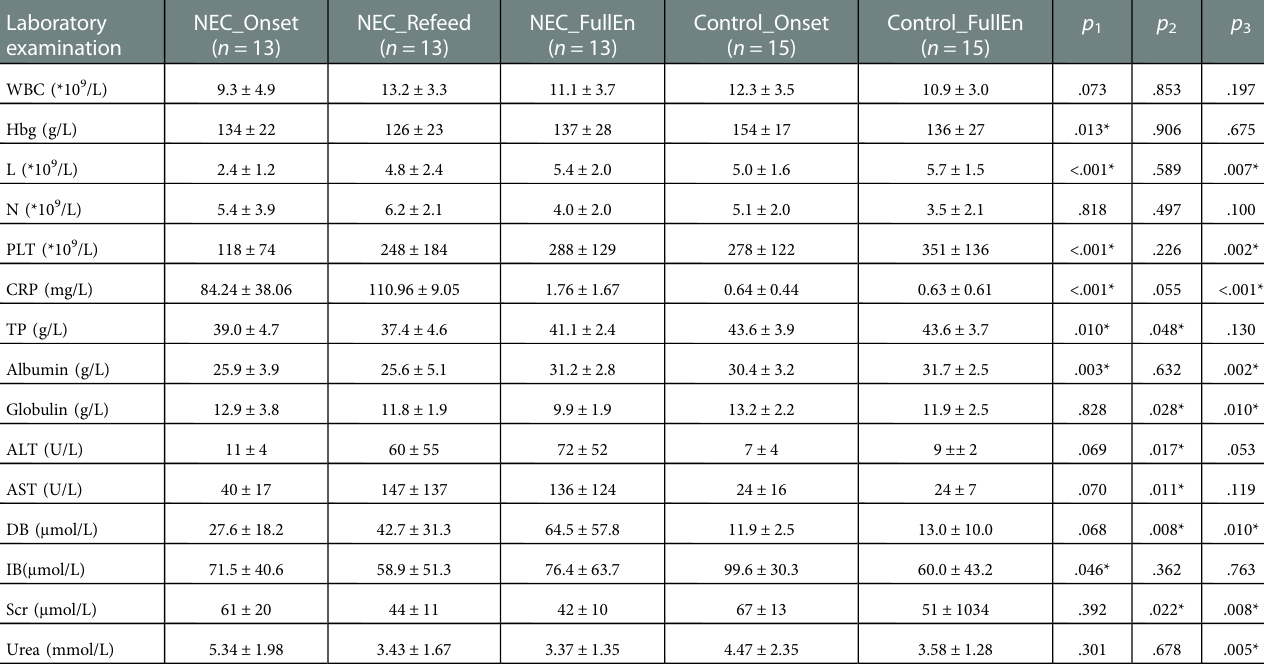
TABLE 3 Laboratory examinations among different